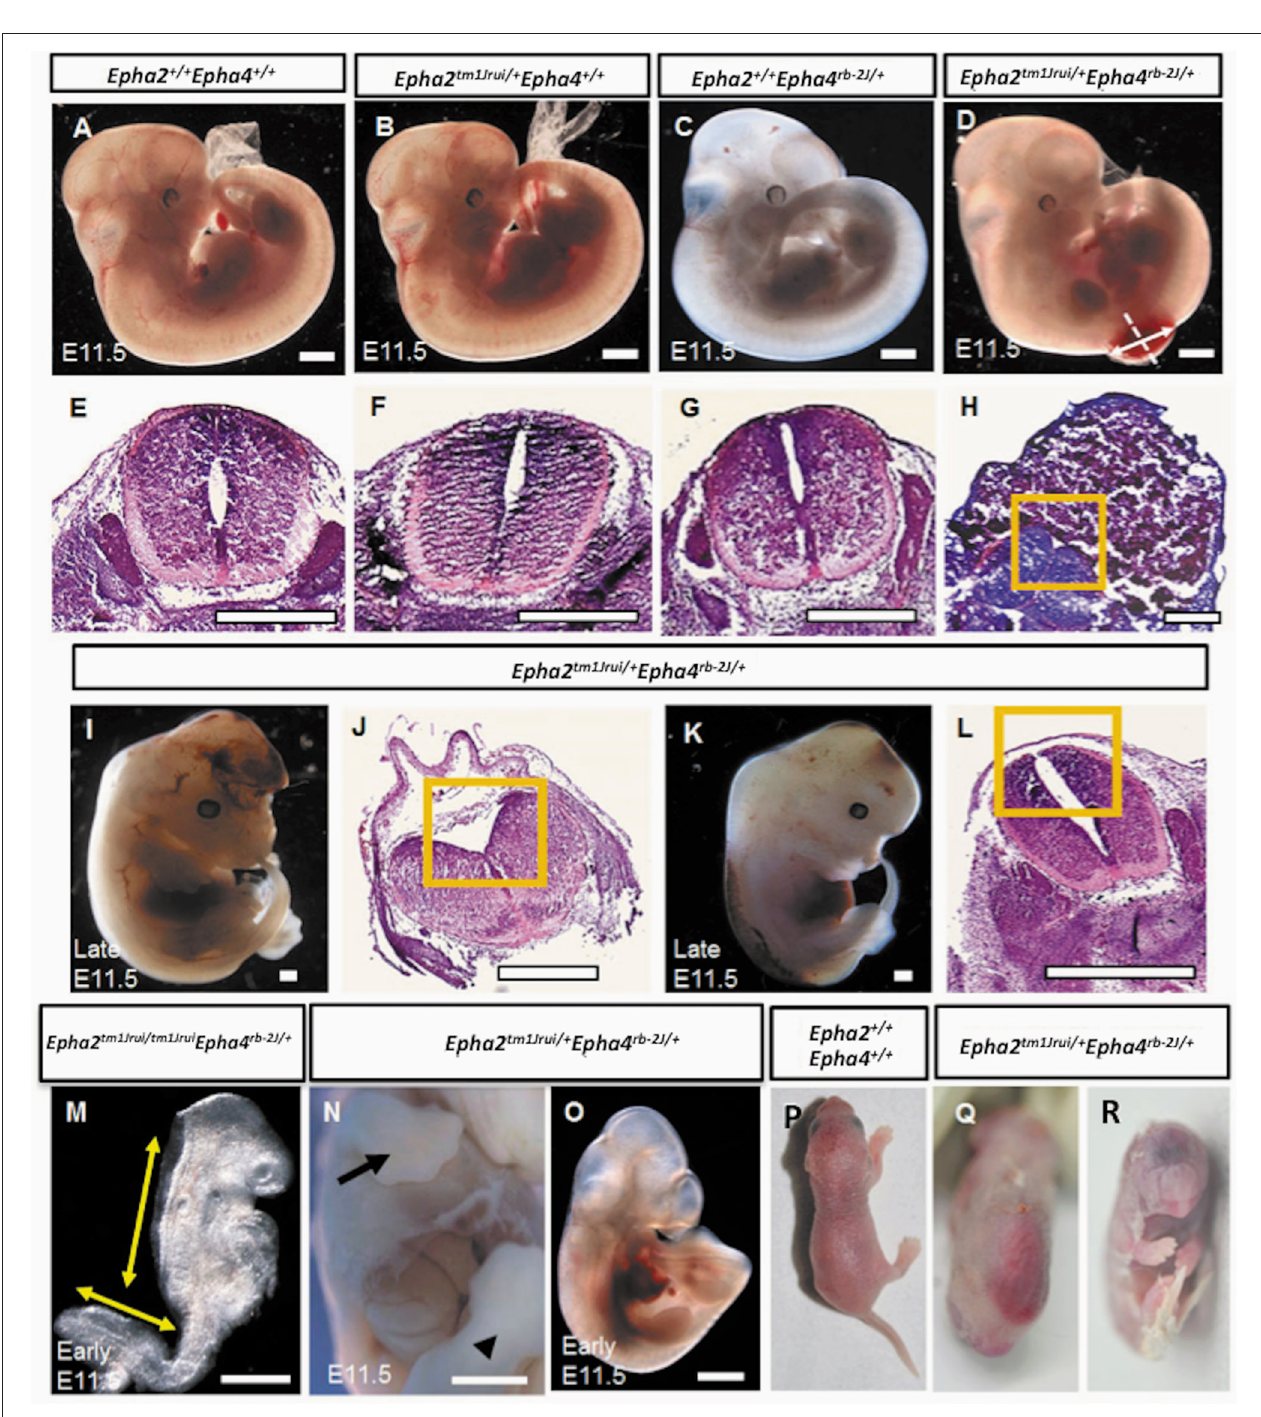
FIGURE 1 | Phenotypes of the Epha2 tm 1 Jrui / + EphAa4 rb − 2 J / + embryos and pups. (A). Wildtype Epha2 + / + Epha4 + / + embryo. (B) Epha2 tm 1 Jrui / + Epha4 + / + embryo. (C) Epha2 + / + Epha4 rb − 2 J / + embryo. (D) . Mutant E11.5 embryo with a close spinal neural tube defect (NTD). (E–H) The neural folds of the neural tube shown by transverse tissue sections of the embryos in (A–D) respectively. Dotted line in (D) indicates level of section in (H) . The diameter of the lesion is 0.75mm (shown by double arrow). (H) Section of the lumbosacral sac revealing elevated neuroepithelium ensconced in cytoplasmic tissue. (I) Embryo with close exencephaly. (J) Cranial neural tube section revealed unfused cranial neural tube. (K) Embryo with close spinal neural tube. (L) Elevated neural folds failed to fuse. (M) An early E11.5 axial rotation defect embryo exhibiting elevated neural folds that failed to fuse from the cranial region down to the thoracic region and the unfused spinal neural folds. (N,O) Embryos with defects other than neural tube; (N) with gastrochisis and (O) with caudal dysgenesis. Forelimb and hindlimb in (N) embryo shown by arrow and arrow head respectively. (P,Q) A day old newborns. (P) Wildtype. (Q) Mutant pup with close NTD. (R) Mutant pup with cyclopia. Boxed region in (H,J,L) represents the opposing neural folds which failed to fuse. Scale bar represents 0.5mm.